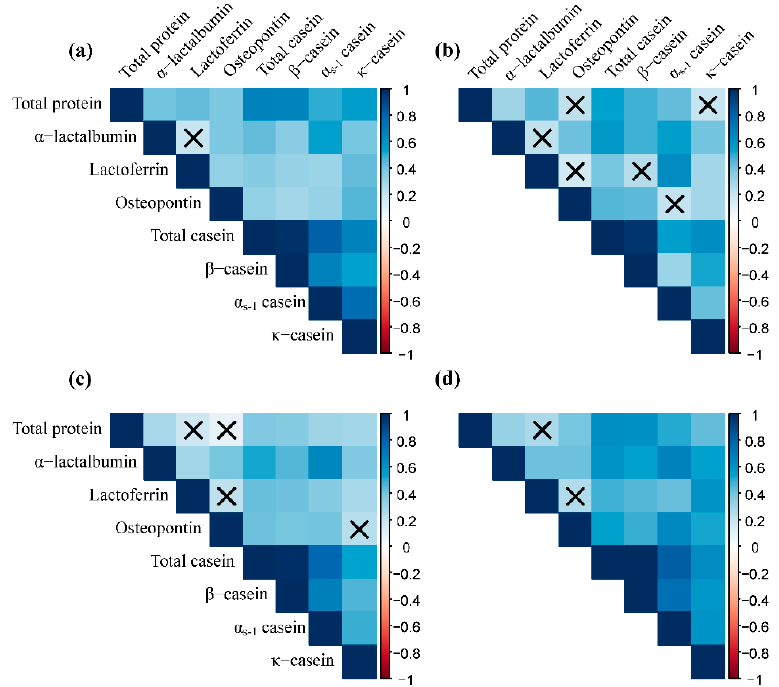
Figure 1. Correlation between human milk proteins. × p ≥ 0.05. The color in the square represents the value of the correlation coefficient. Samples with concentration information on all eight human milk indices were included in the analysis (number of participants: 51). Correlation coefficients were calculated by Pearson correlation. The values of lactoferrin concentration were transformed to log scale before analysis: ( a ) 1–5 days postpartum, ( b ) 8–14 days postpartum, ( c ) 1 month postpartum, and ( d ) six months postpartum.